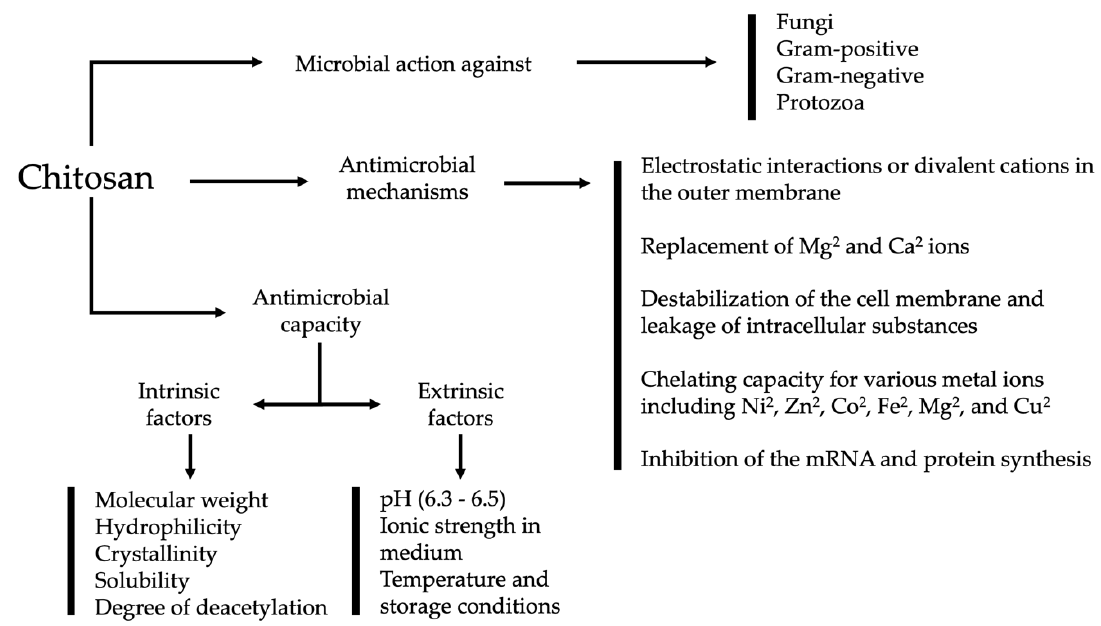
Figure 2. Antimicrobial mechanisms of chitosan.